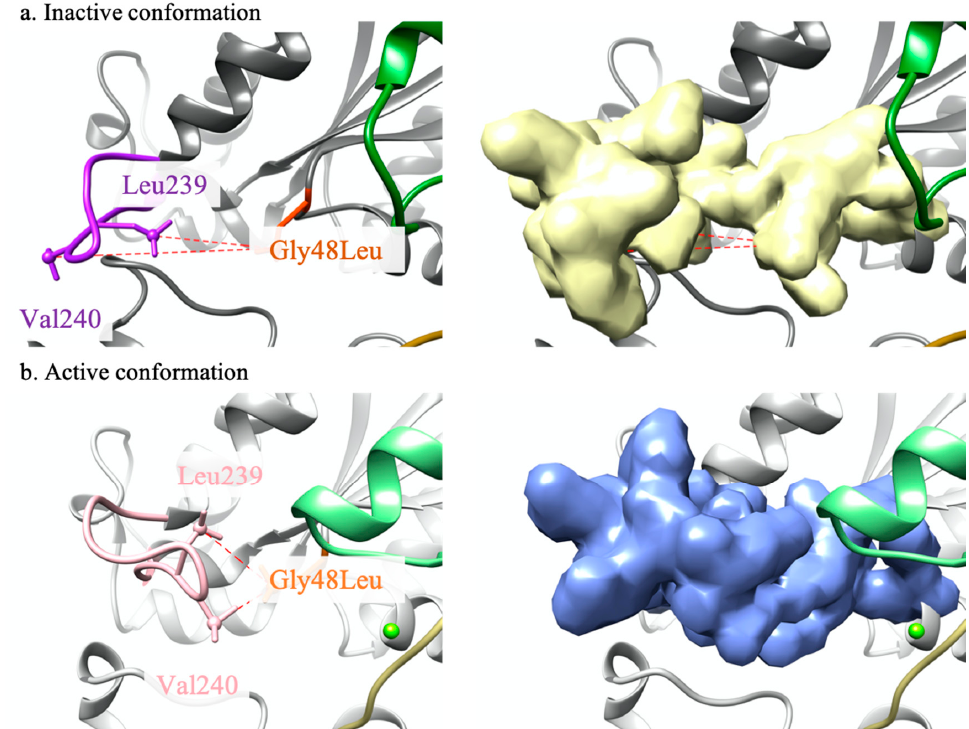
Figure 3. Distance comparison. ( a ) Inactive conformation of p.Gly48Leu G α q mutant (PDB ID